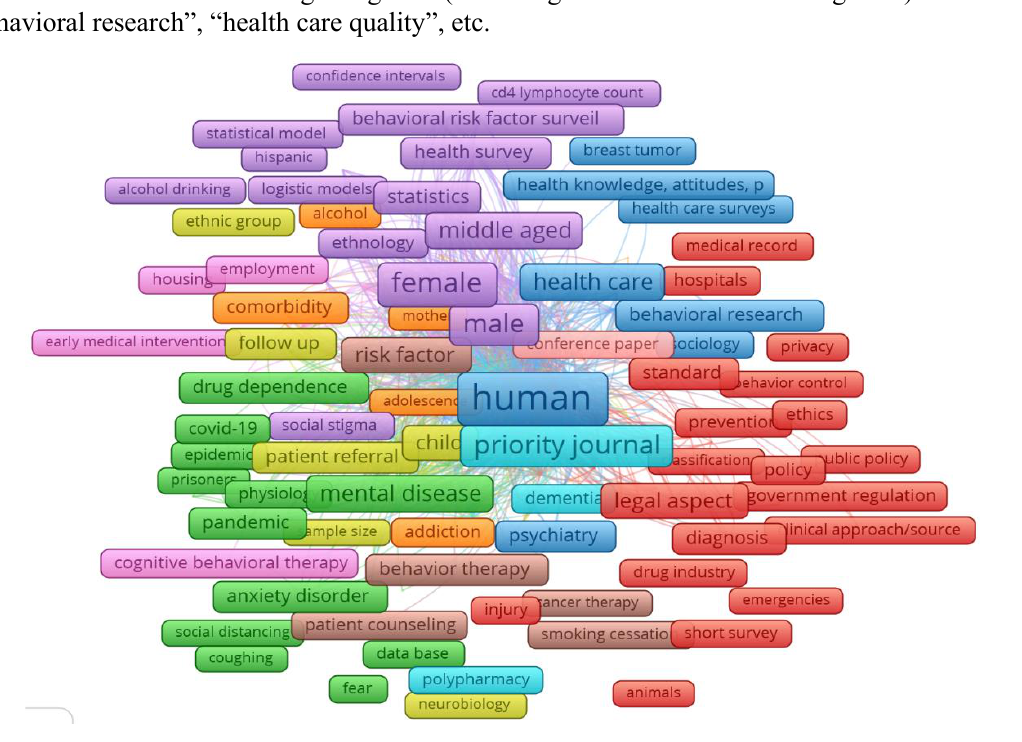
Figure 1. Scientific bibliography of the categories “health care system, medical services, behavioral aspect, social aspect” for 2000-2020 using software